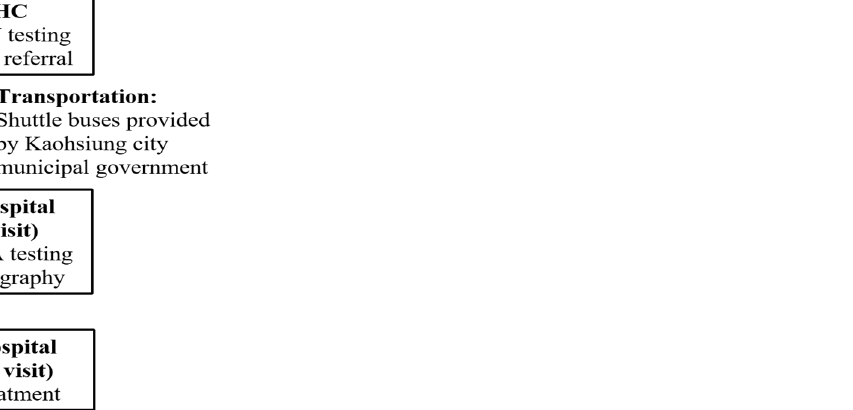
Figure 1. Referral model between LDPHC and E-Da hospital. LDPHC, Liouguei District Public Health Center; DAAs, direct-acting antivirals;